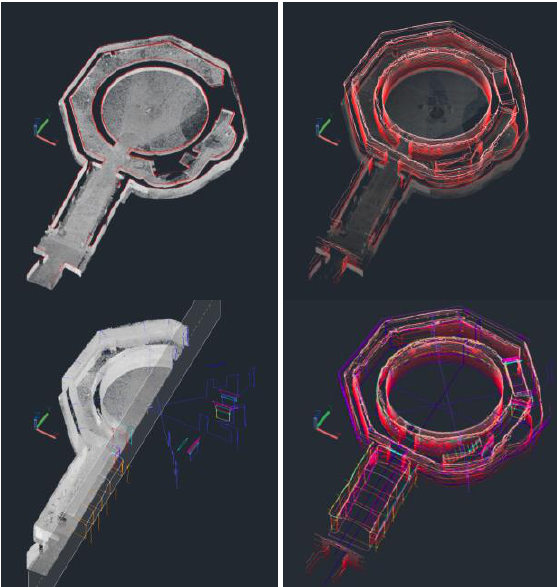
Fig. 7. The complexity of geometry required tracing from point clouds at different horizontal and vertical planes.